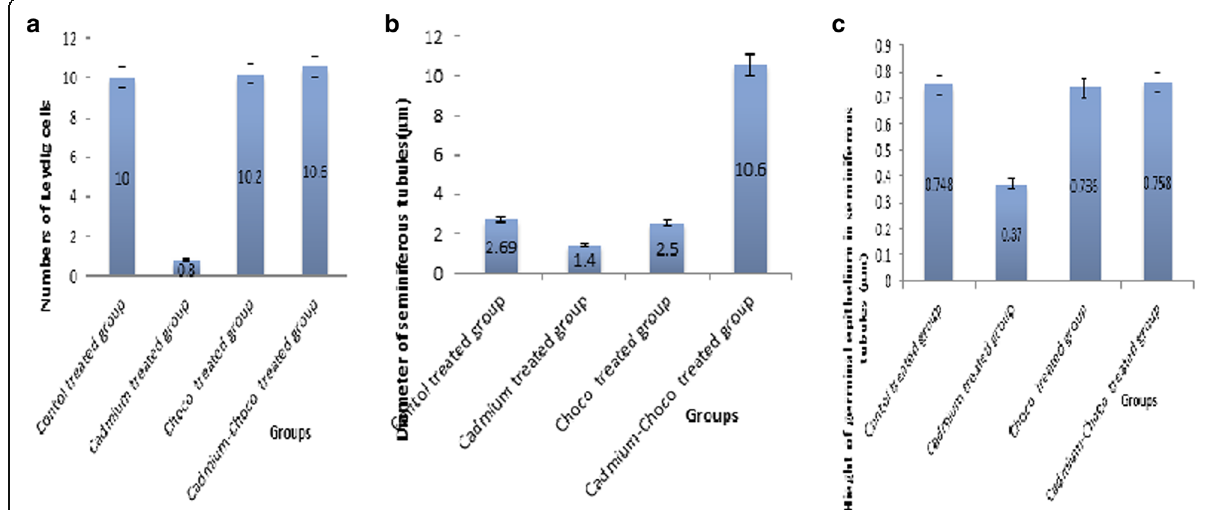
Fig. 5 Histomorphometrical analysis of testicular tissues from mice treated with cadmium and/or nano-chocolate fortified with zinc nanoparticles. a Number of Leydig cells. b Diameter of seminiferous tubule ( μ m). c Height of germinal epithelium ( μ